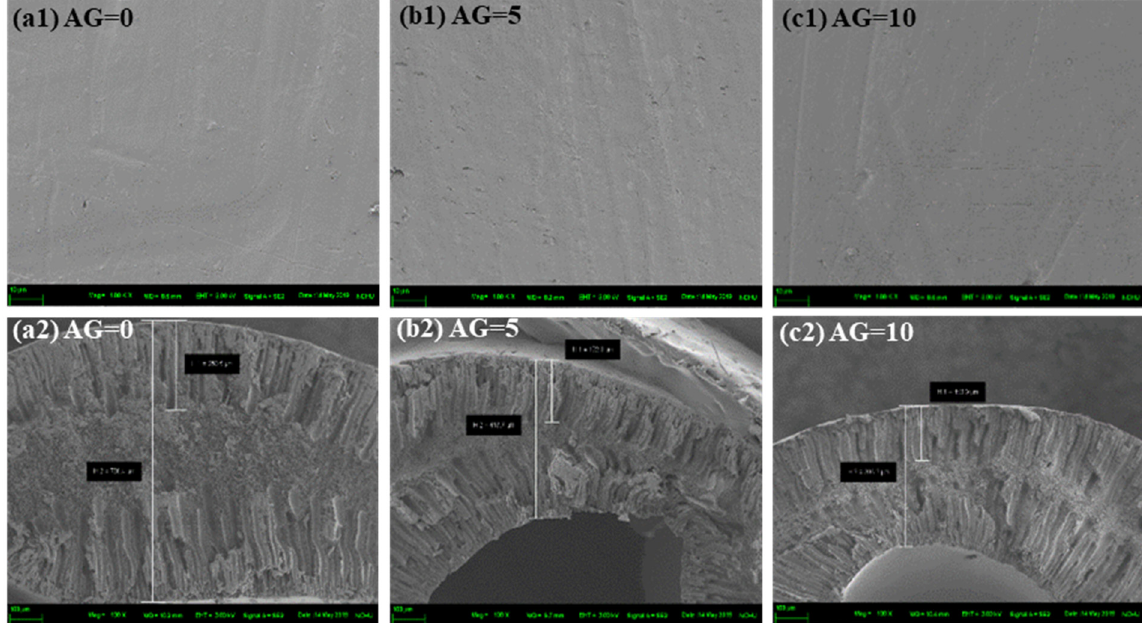
Figure 2. The outer-surface ( top ) and cross-section ( bottom ) SEM images of MMHFMs spun with different air gap dis- tances: ( a1 , a2 ) AG0-R5.14-1000 nm, ( b1,b2 ) AG5-R5.14-1000 nm, and ( c1 , c2 ) AG10-R5.14-1000 nm. Table 2. The effect of the air gap distance on the membrane